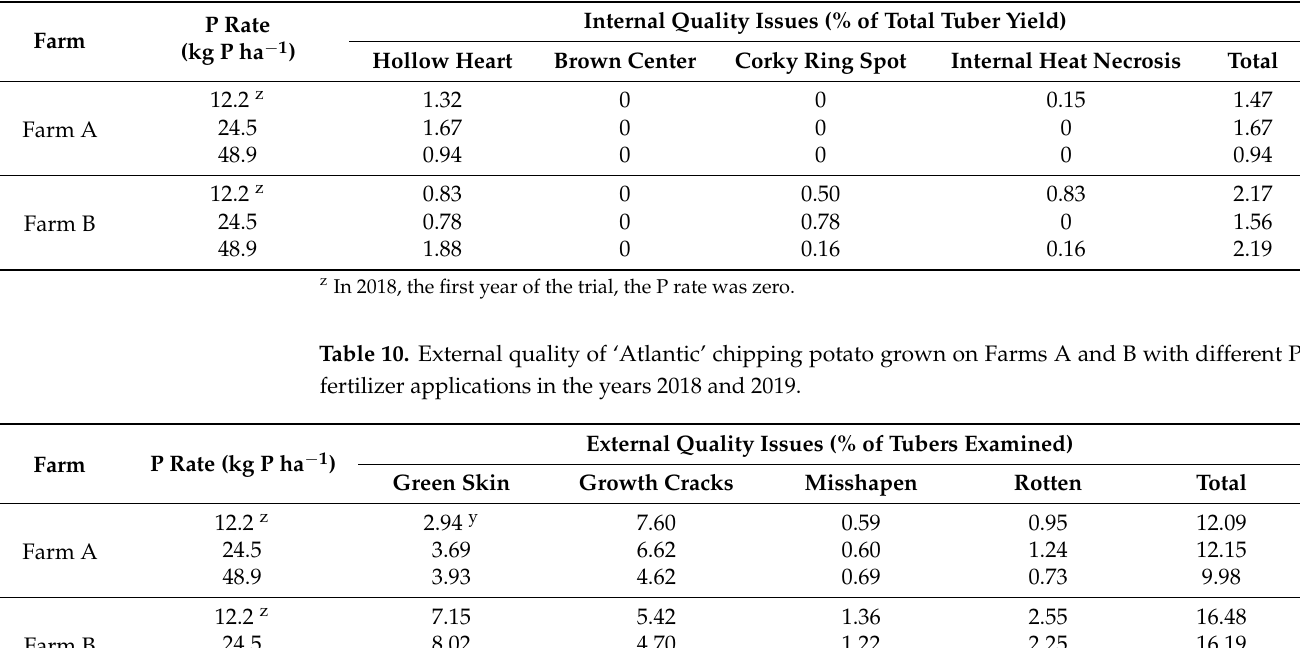
Table 9. Internal quality of ‘Atlantic’ chipping potato grown on Farms A and B with different P fertilizer applications in the years 2018 and 2019.